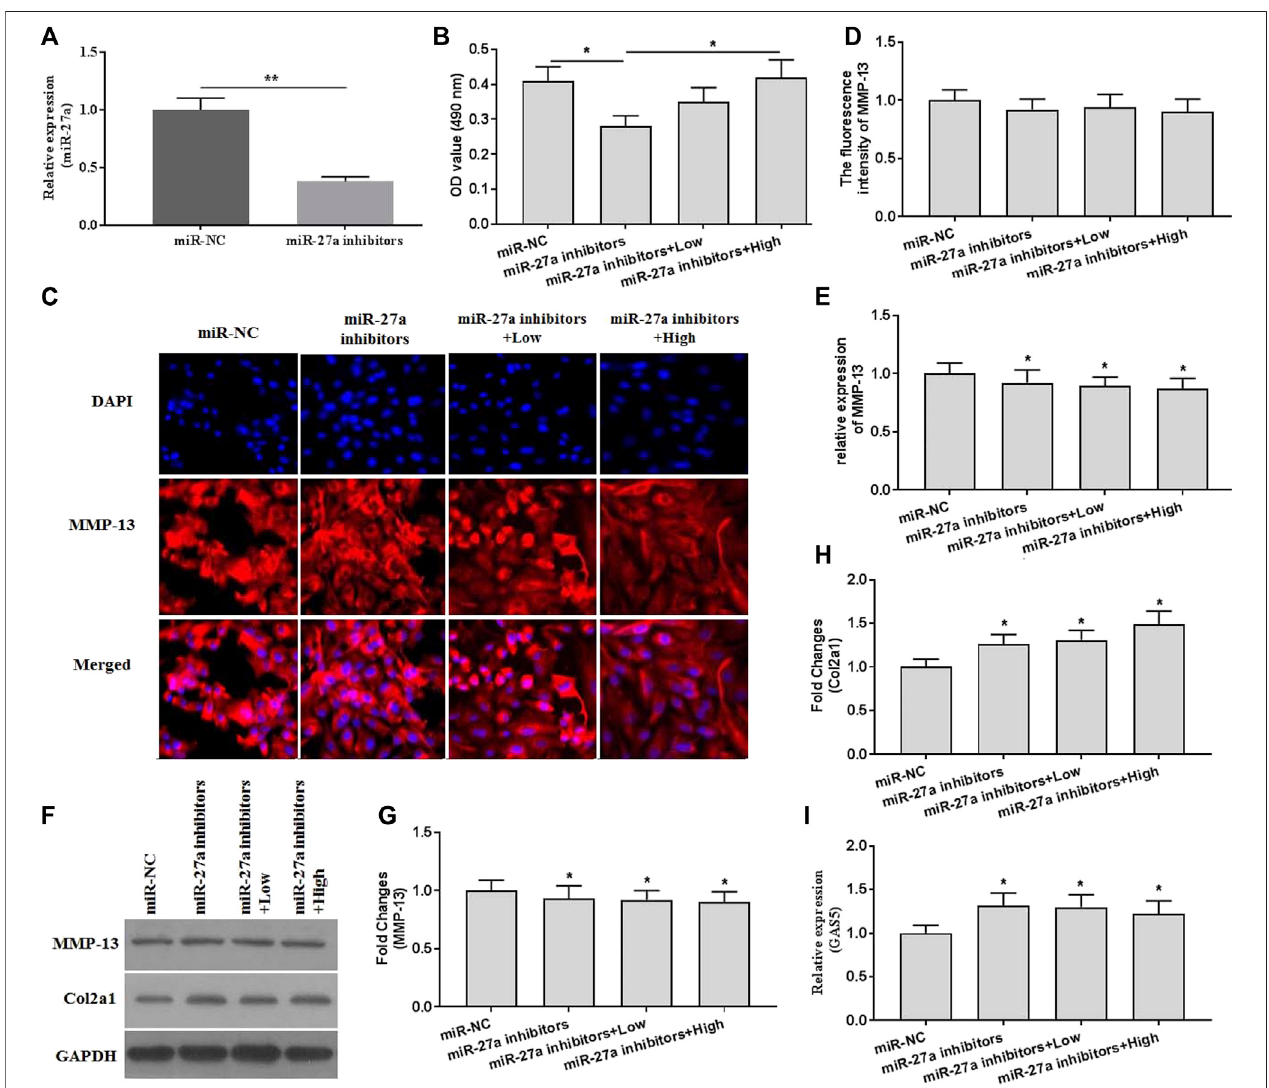
FIGURE 6 | The effects of XH on the expression of MMP-13 in miR-27a inhibitor-transfected chondrocytes with mechanical stimulation were investigated. (A) The expression of miR-27a was determined by qRT-PCR in miR-27a inhibitor-transfected chondrocytes. (B) The cell viability was determined by CCK-8 assays after mechanical stimulation for 24 h. (C) The immuno fl uorescence intensity of MMP-13 was determined. (D) The calculation of fl uorescence activity of MMP-13. The mRNA (E) expression ofMMP-13wasdeterminedbyqRT-PCR,and theprotein expression ofMMP-13 (F-G) and Col2a1 (F and H) weredetermined bywesternblotting assays. (I) TheexpressionofGAS5wasdeterminedbyqRT-PCRinmiR-27ainhibitor-transfectedchondrocytes.* p < 0.05and** p < 0.01.NC,negativecontrol;Low,XH (5 μ M); High, XH (20 μ M).